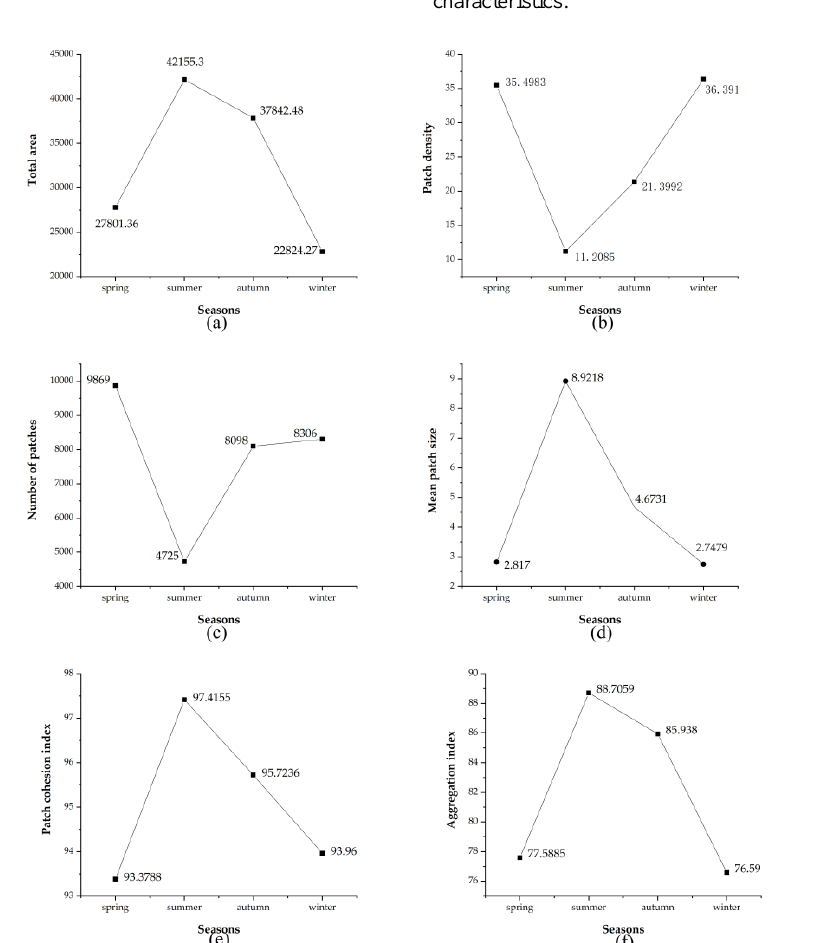
Figure 5. Landscape metrics of urban heat regions, (a) TA; (b) PD;(c) NP; (d) MPS; (e) PCI; (d)